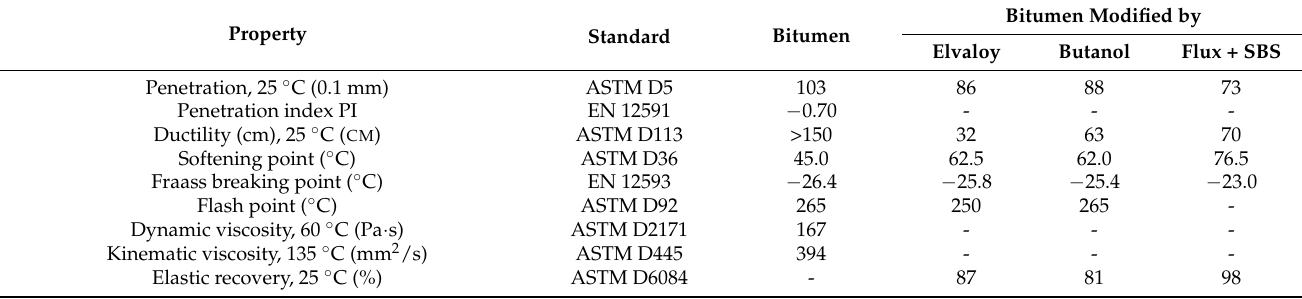
Table 1. Conventional properties of